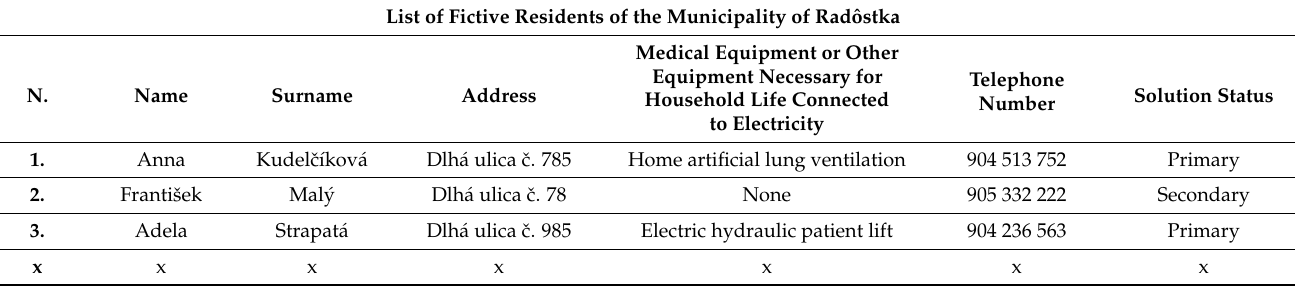
Table 5. Draft list of needs of the